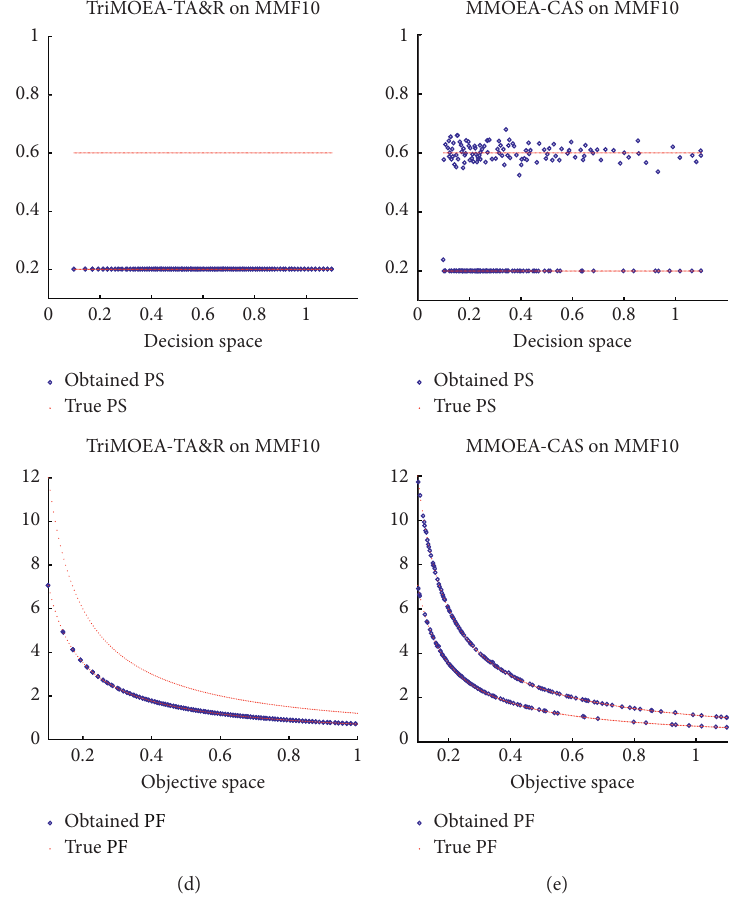
Figure 3: The final populations obtained in decision and objective spaces on